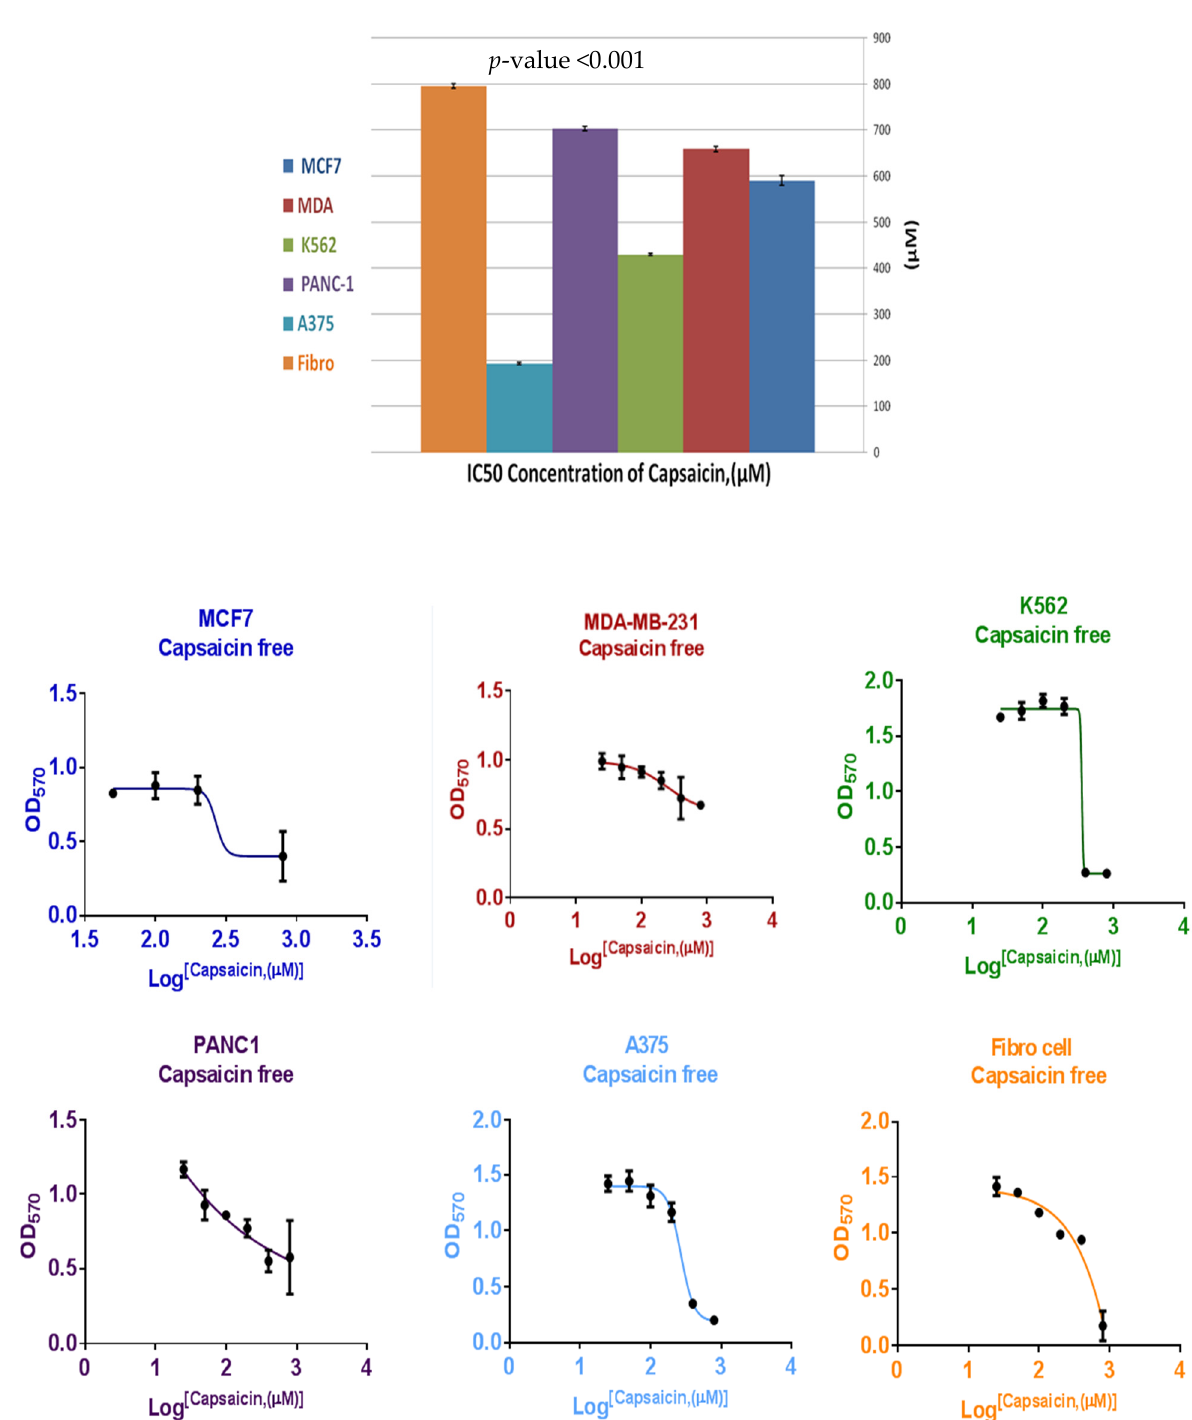
Figure 6. Cytotoxicity and the half maximal inhibitory concentration (IC 50 ) of CAP against human fibroblasts normal cells as negative control and against human cancer cell lines (MCF7, MDA-MB-231, A375, K562 and PANC-1).